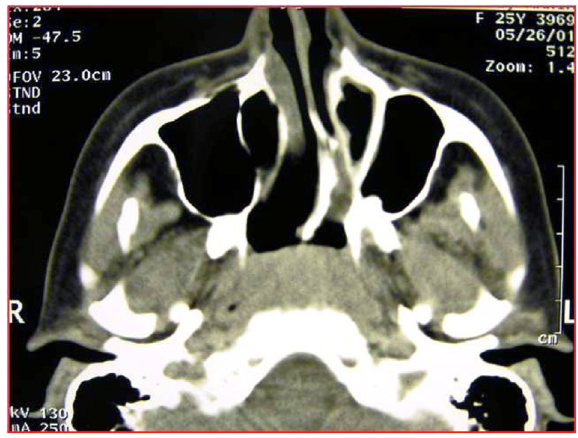
Figure 2 Axial CT scan, monolateral left mixed choanal atre- sia.